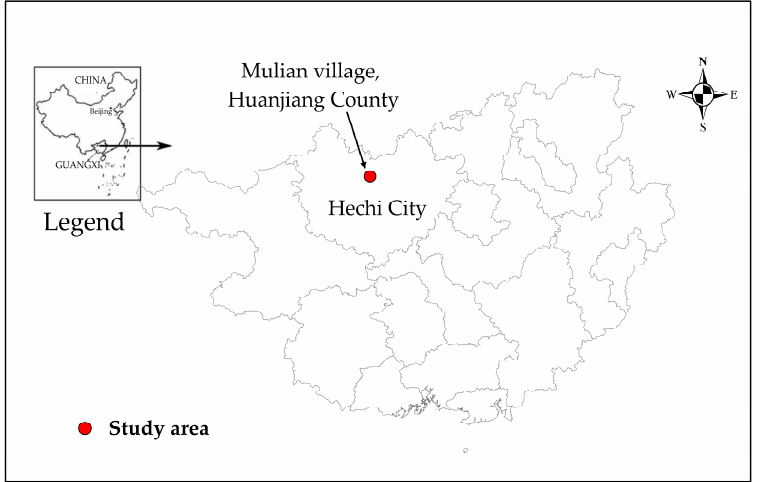
Figure 1. Study area bitmap.